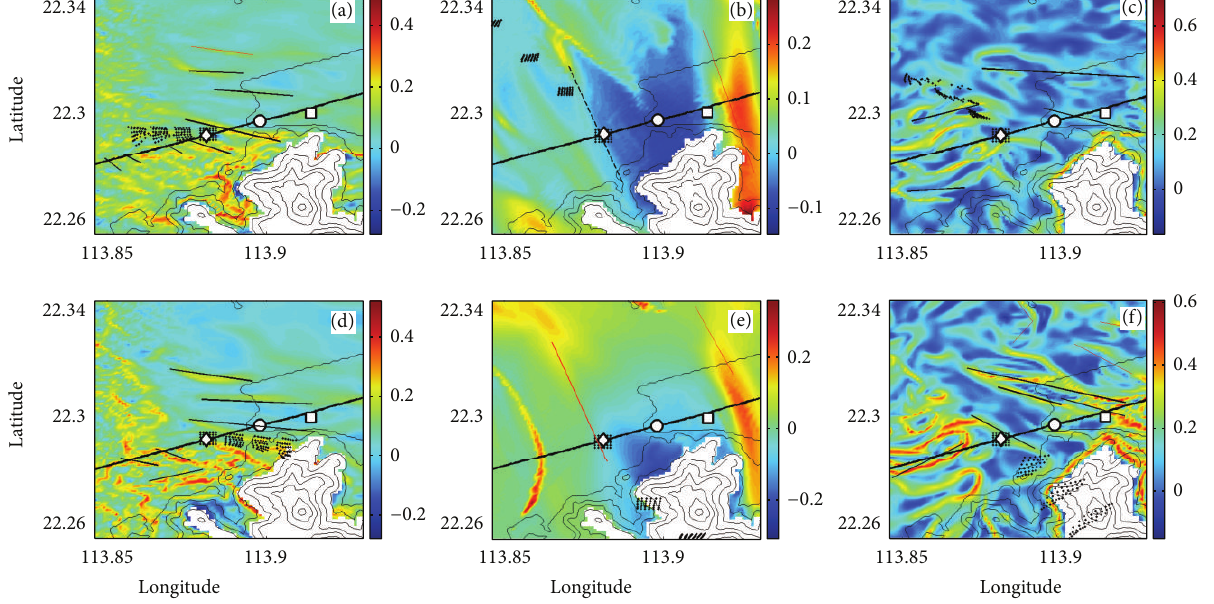
Figure 7: FTLE fields computed from just horizontal stretching. The panels are, from left to right, data from RAMS, FLOWSTAR, and WRF, respectively. The top panels are the forward time FTLE and the bottom panels are the backward time